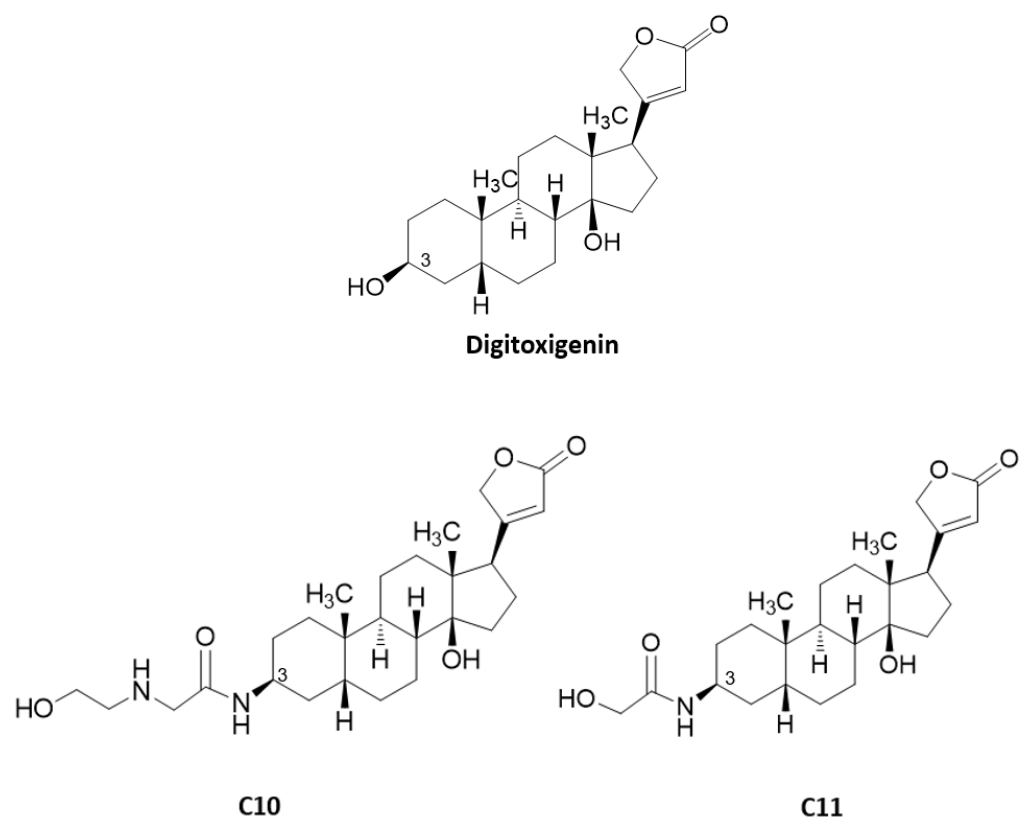
Figure 2. Chemical structures of digitoxigenin, C10 , and C11 derivatives.